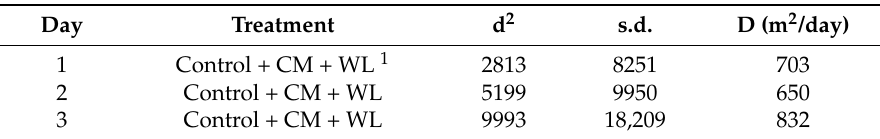
Table 3. Mean squared distances (d 2 ) and dispersal constants (D) of Anartia fatima during the first three days following their September release.